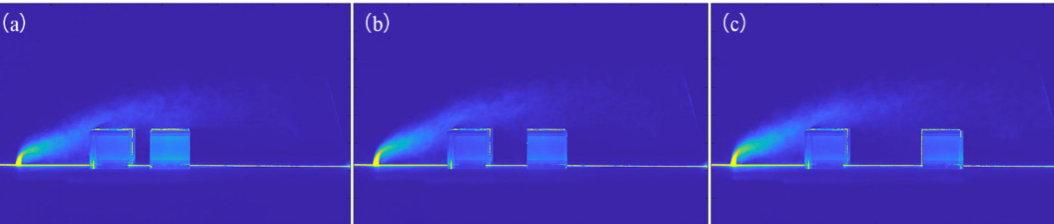
Figure 12. Time-averaged concentration fields on the vertical plane (y = 0) with different aspect ratio streets: ( a ) R w = 2.0; ( b ) R w = 1.0; ( c ) R w =